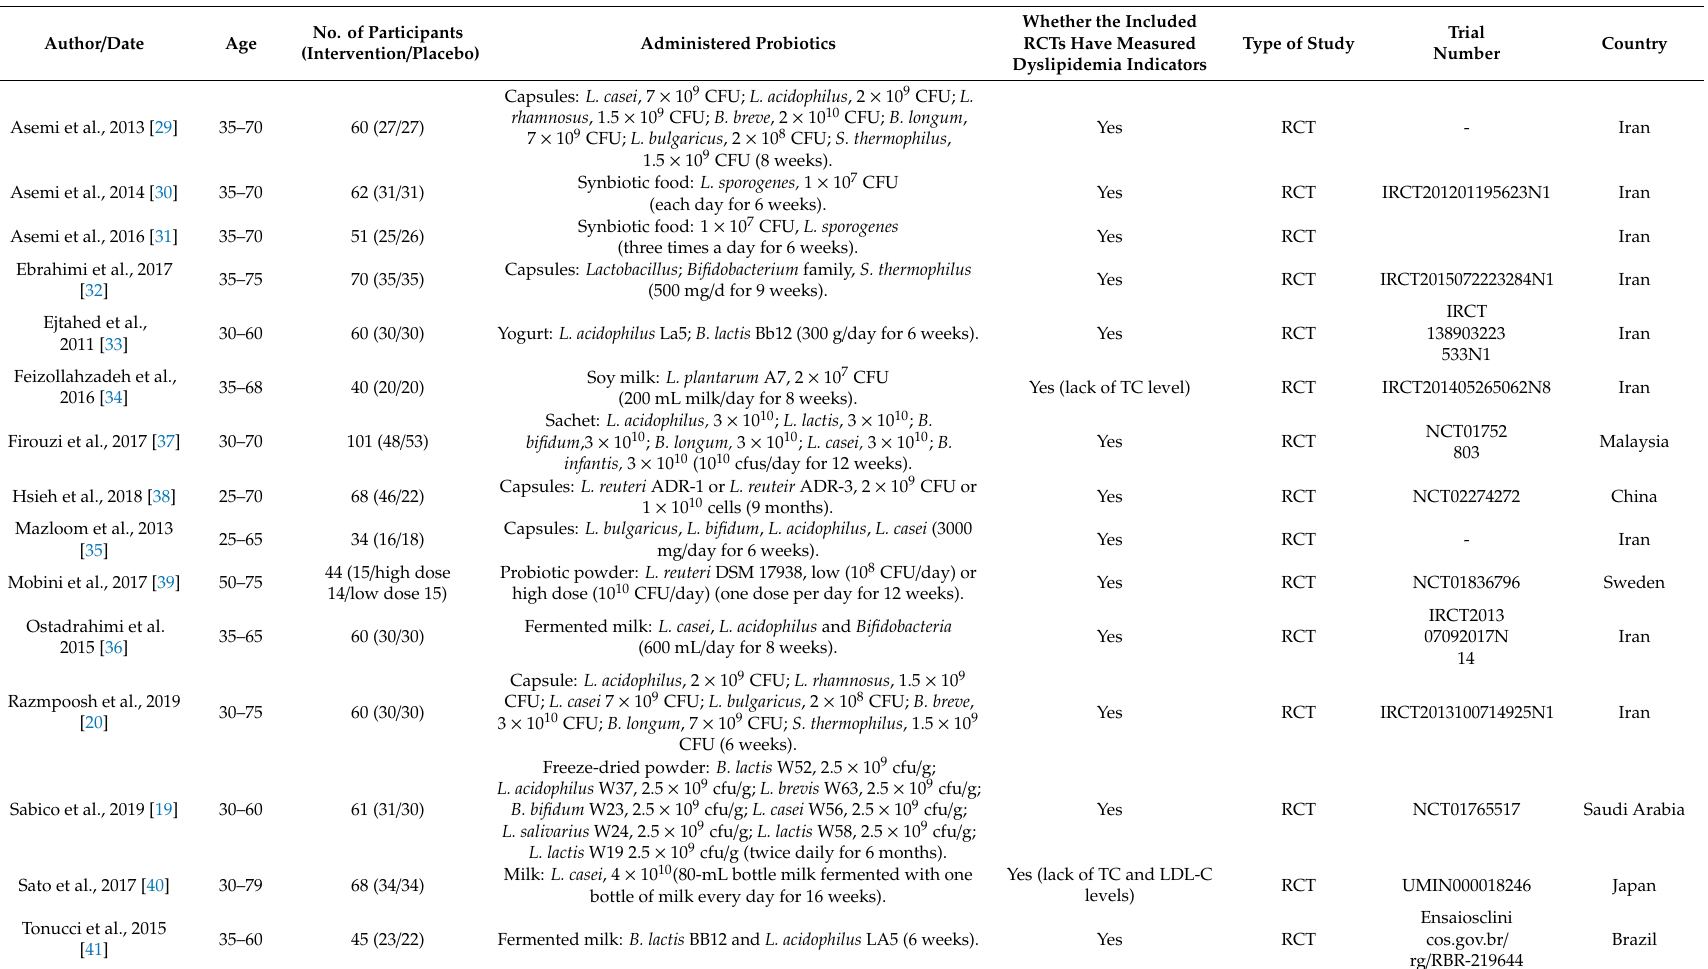
Table 1. Characteristics of included randomized controlled trials (RCTs) in this